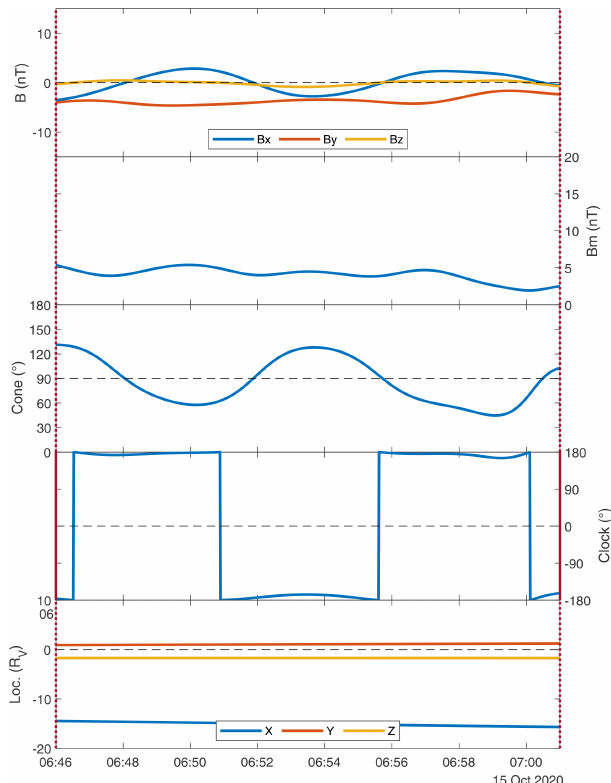
Figure 7. Zoom-in on the magnetotail flapping interval (red). The cone angle clearly shows alternating magnetic field directions (tail- ward θ c > 90 ◦ and Venus-ward θ c < 90 ◦ ). The clock angle remains basically the same ( φ c = 180 ◦ ≡ φ c = − 180 ◦